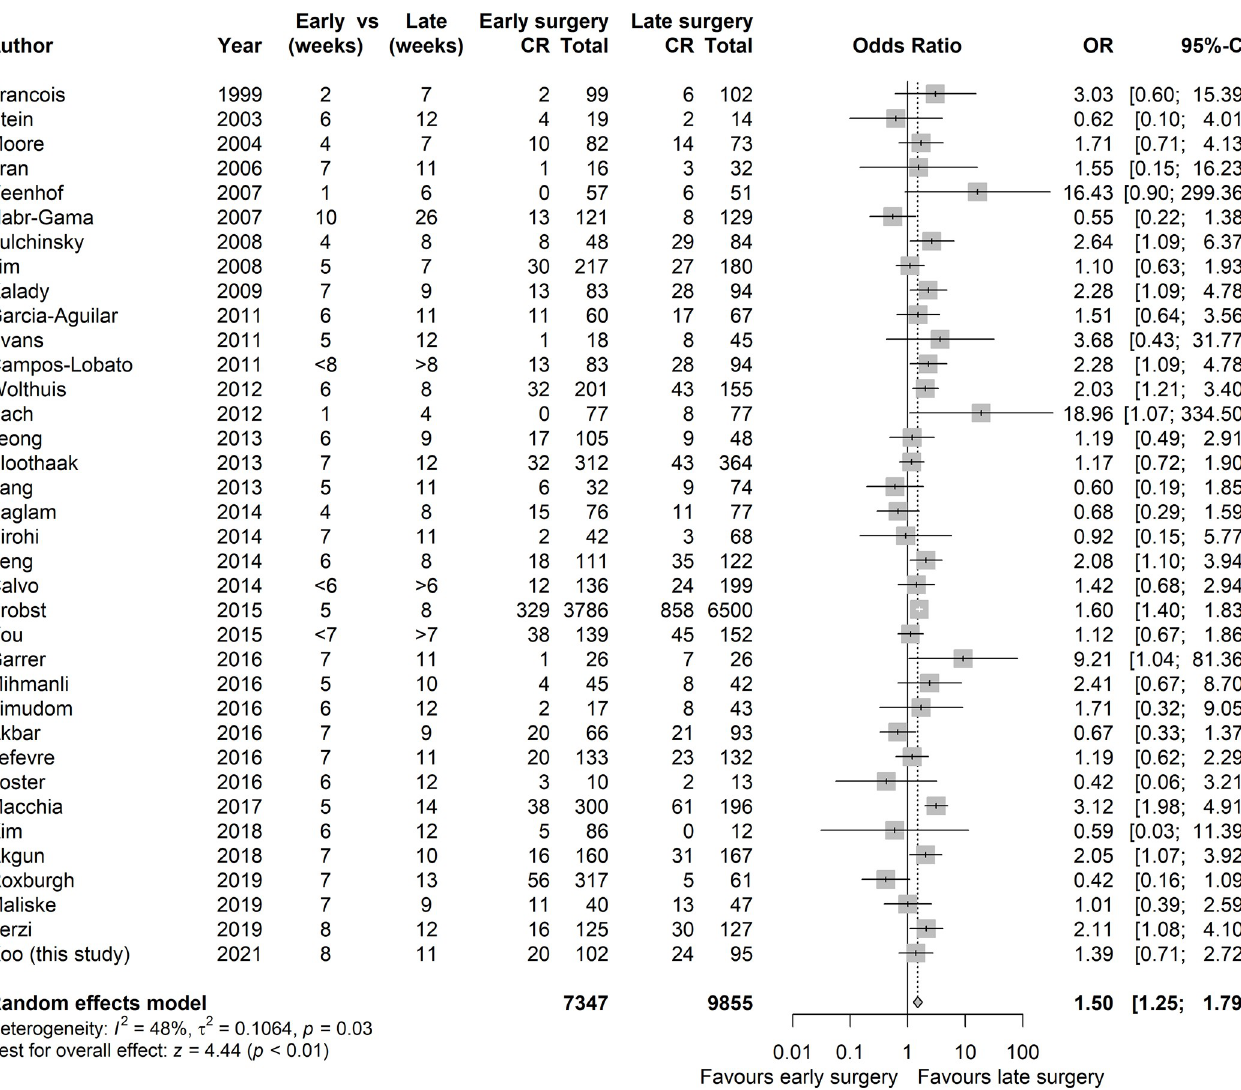
Fig 4. Meta-analysis of delay to surgery after neoadjuvant radiotherapy. Meta-analysis of 36 studies (17355 patients) comparing early versus late surgery after neoadjuvant radiotherapy. Studies are listed by year of publication. The median delay to surgery (in weeks) in the “early” and “late” surgery groups is provided. For the 3 studies where exact delay to surgery was unavailable, the delay threshold has been listed (with < or > signs).